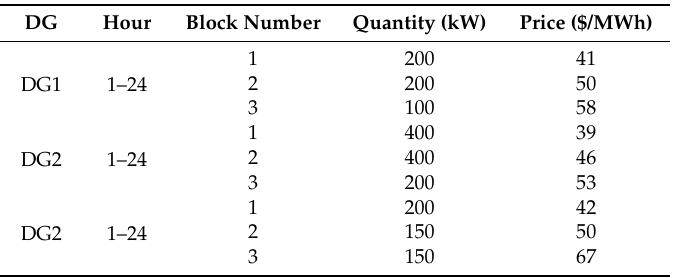
Table 1. Price-Quantity offer of